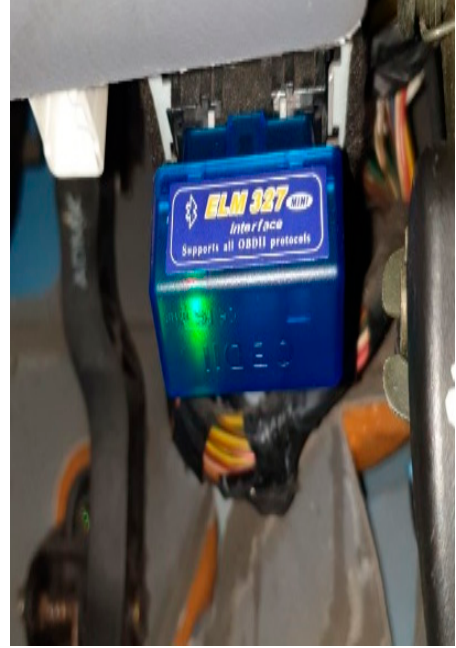
Figure 1. Installation of ELM327 inside the vehicle.